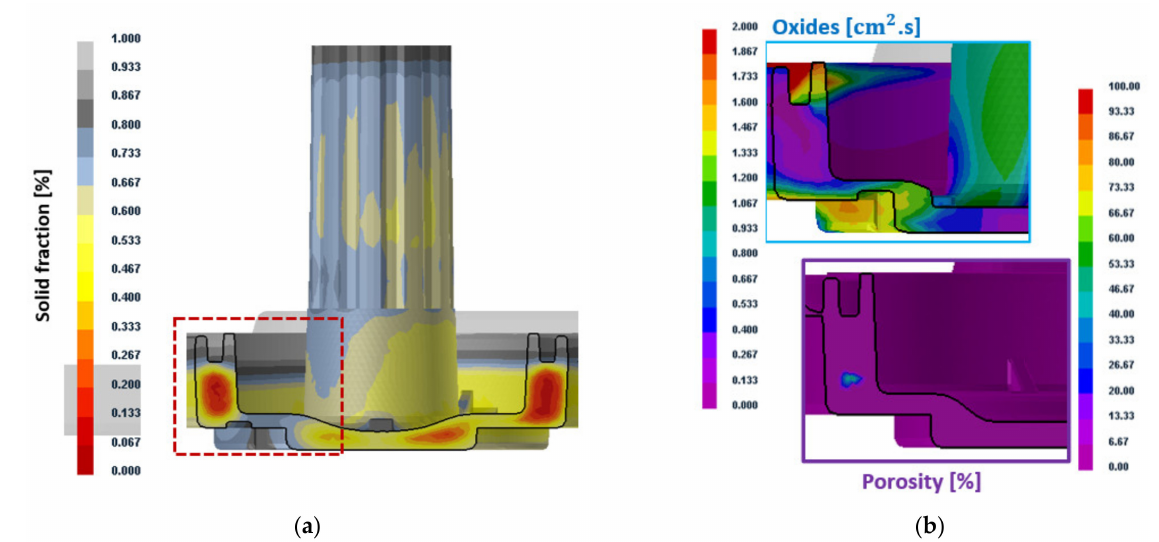
Figure 12. A-A cut through the casting shown in numerical simulation: ( a ) Display of hot spots; ( b ) Display of prediction of the presence of oxides and pores.